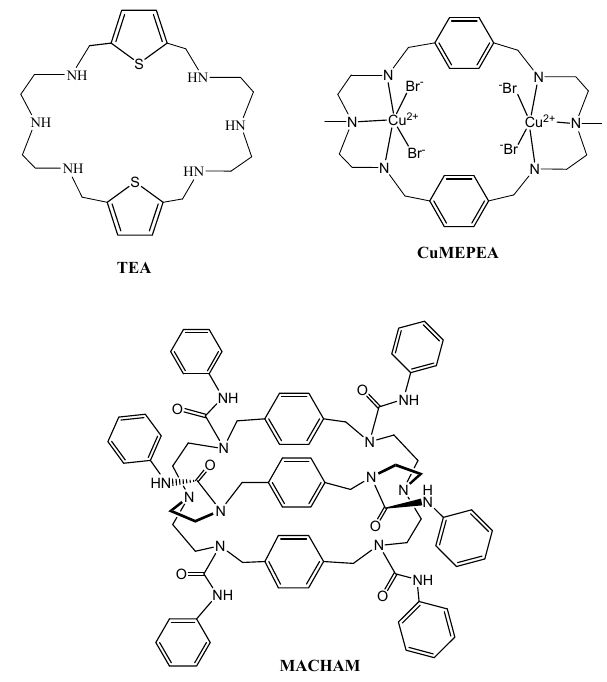
Figure 2. Chemical structures of cyclic receptors: TEA (Thiophene-based Ethylene Macrocyclic Amine), CuMEPEA (Copper(II) complex of Methylated Para-xylyl-based Ethylene Macrocyclic Amine) and MACHAM (Macrocyclic Amide).